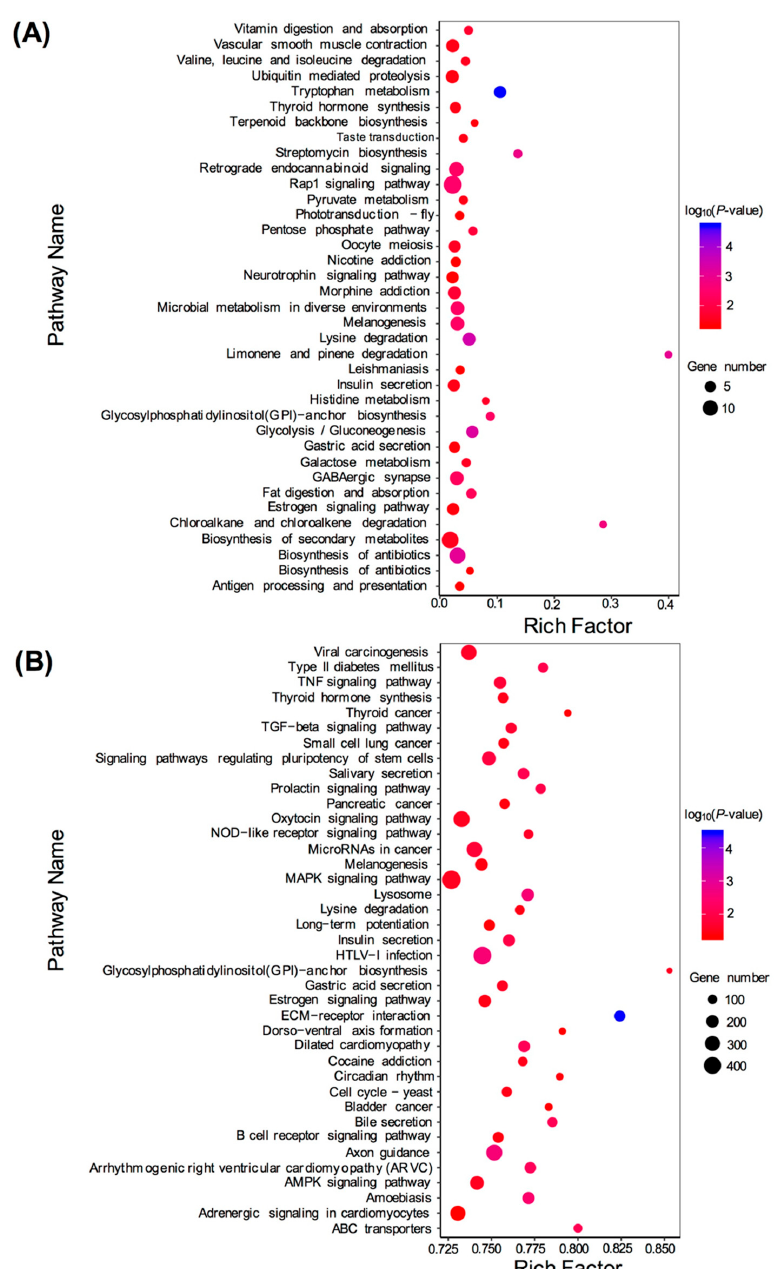
Figure 6. Kyoto Encyclopedia of Genes and Genomes (KEGG) pathway enrichment analysis of the target genes of differentially expressed miRNAs (DEMs). ( A ) Significantly enriched pathways of the target genes of known DEMs (TM vs. WT); ( B ) Significantly enriched pathways of the target genes of novel DEMs (TM vs. WT).